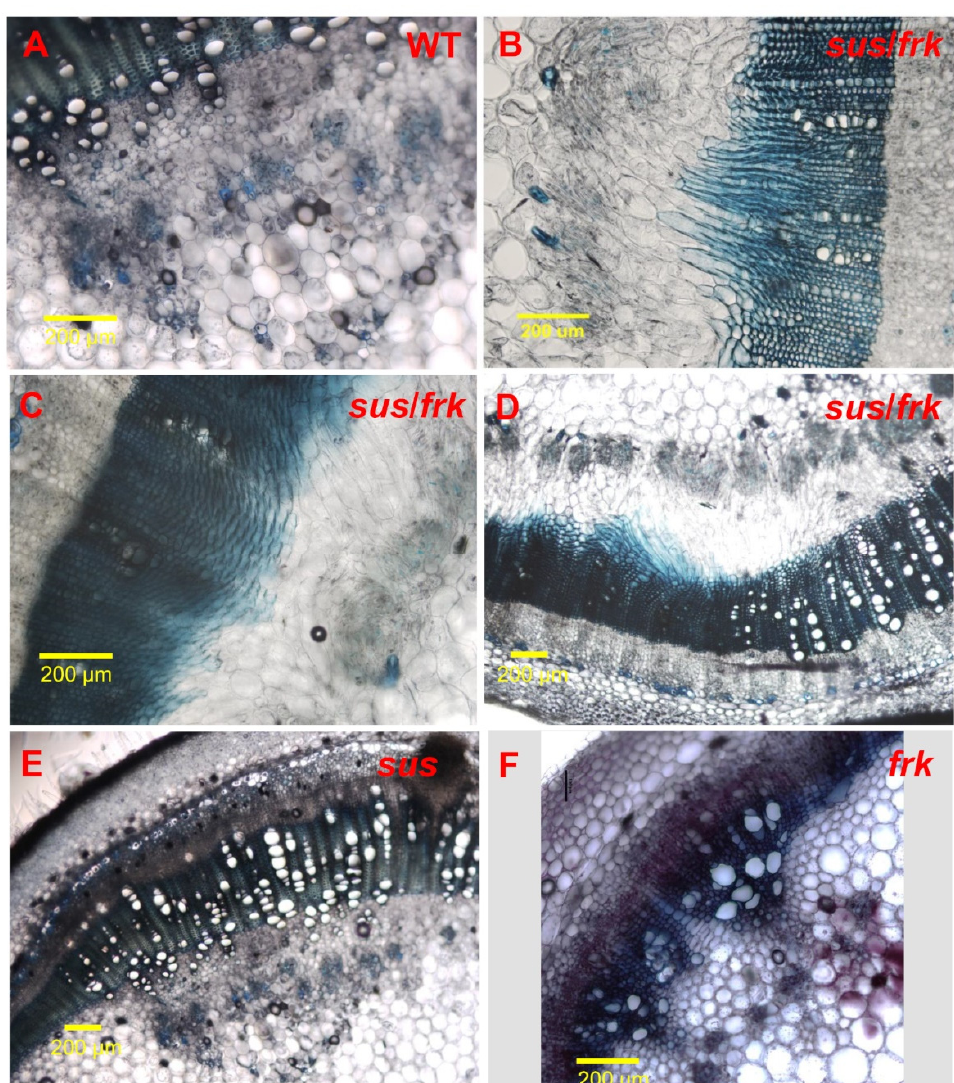
Figure 8. Abnormalities in the vascular tissue of the sus / frk stem. ( A ) Cross-section of a WT stem. ( B – D ) Cross-sections of sus / frk stems with disoriented xylem parenchyma cells. ( E ) Cross-section of a sus stem. ( F ) Cross-section of a frk stem.